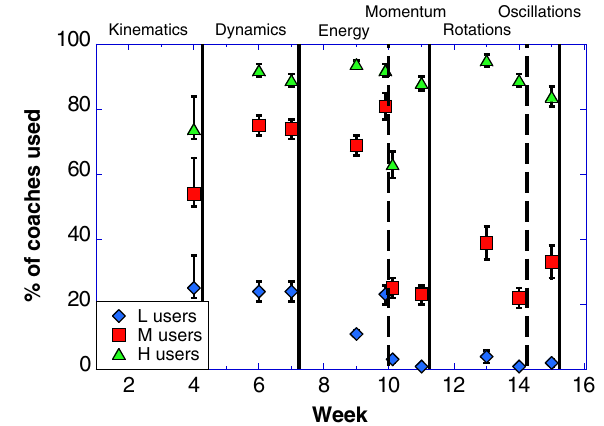
FIG. 7. Use of the computer coaches as a function of time throughout the spring 2013 course by students in each of the three usage groups. A database error prevents the calculation of student usage of the coaches in week 3, as well as causes the asymmetric error bars for the week 4 data. The solid vertical lines show the timing of the four in-class tests, which occurred at the end of weeks 4, 7, 11, and 15 of the class. The solid and dashed lines show the boundaries between different topics (labeled at the top of the graph). Usage by students in the L and H groups is relatively constant while usage by M students changes dramatically between the energy and mo- mentum sections of the course, in the middle of the week 10 homework. Spring break occurs between weeks 8 and 9 of the